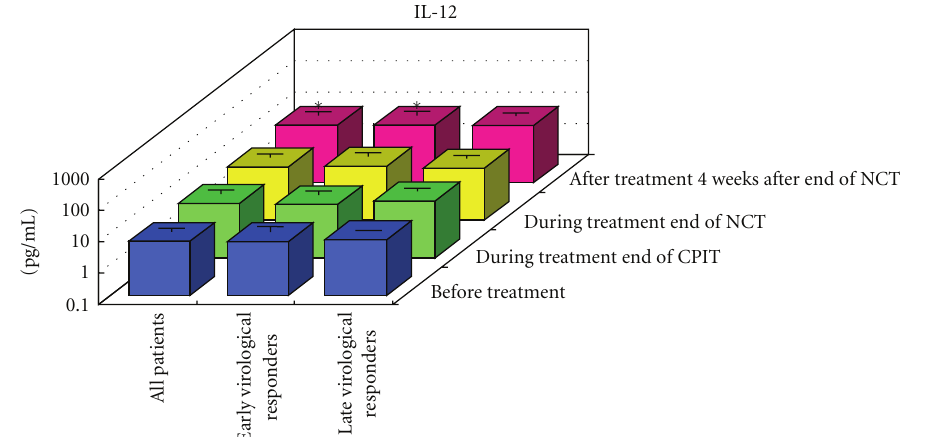
Figure 9: E ff ect of RBV plus PEG-IFN-alpha 2b using an “induction” approach with CPIT (NCT) on serum IL-12 in chronic hepatitis C patients with high viral load, genotype 1b (serotype I), and wild or intermediate type of ISDR. RBV: ribavirin, PEG-IFN: pegylated interferon, CPIT: cyclic and periodic interferon treatment, NCT: novel combination treatment. Significant di ff erence: ∗ P < 0 . 05, ∗∗ P < 0 . 1.